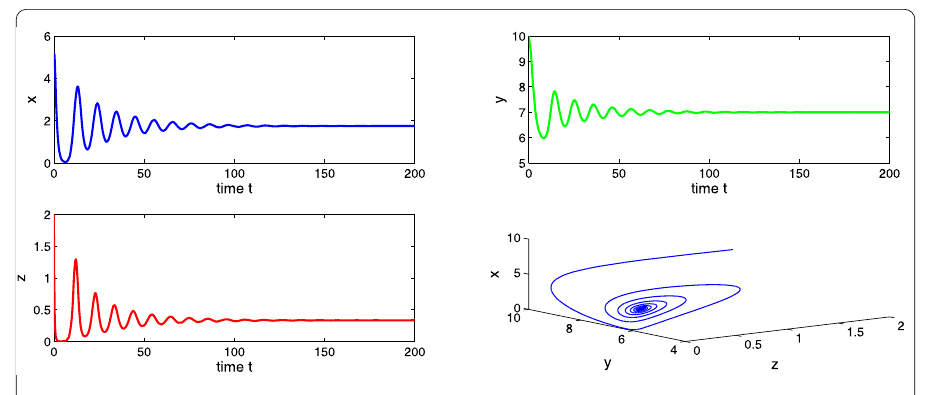
Figure 11 Time evaluation curve and three-dimensional phase portrait of the system for the parameter values a